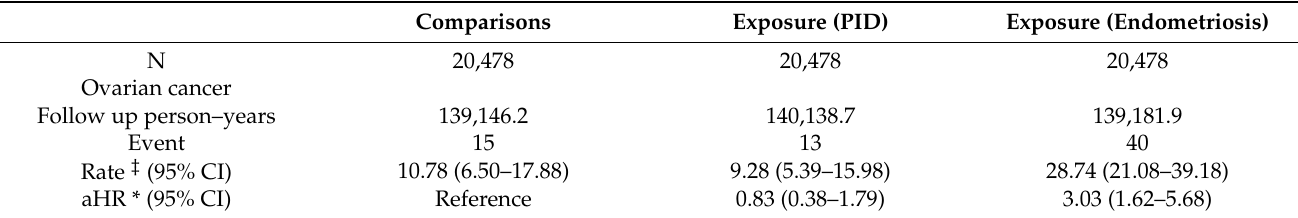
Table 3. Incidence rate and risk of ovarian cancer after performing